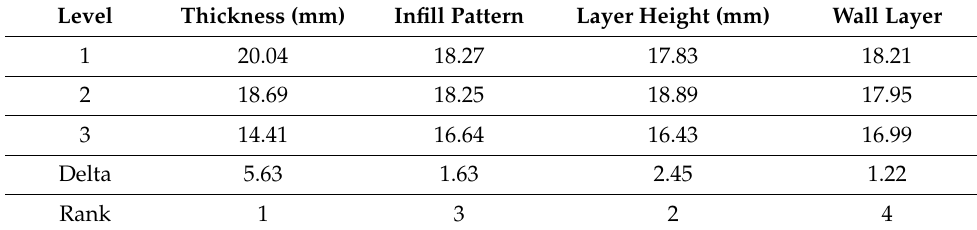
Table 5. Response of variable parameters for circularity.